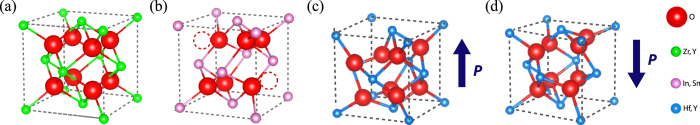
Schematic crystal structures of (a) YSZ (cubic fluorite), (b) ITO (bixbyite), and orthorhombic phase of YHO with (c) upward and (d) downward spontaneous polarization52. For ease of comparison, only one-eighth of the ITO unit cell is depicted. The open, dashed circles indicate unoccupied oxygen sites.